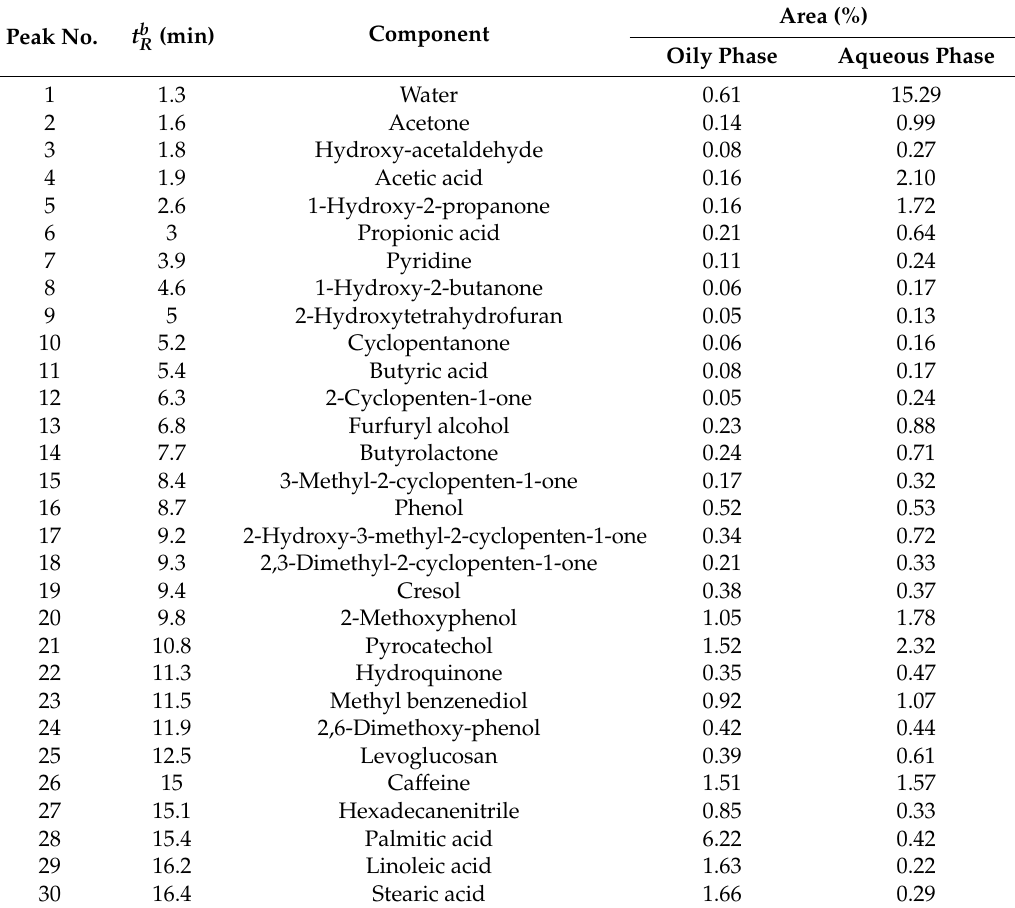
Table 2. List of GC-MS (Gas Chromatography-Mass Spectrometry) area percentages of compounds in oily phase and aqueous phase (Reproduced with permission from [29], Elsevier, 2014).